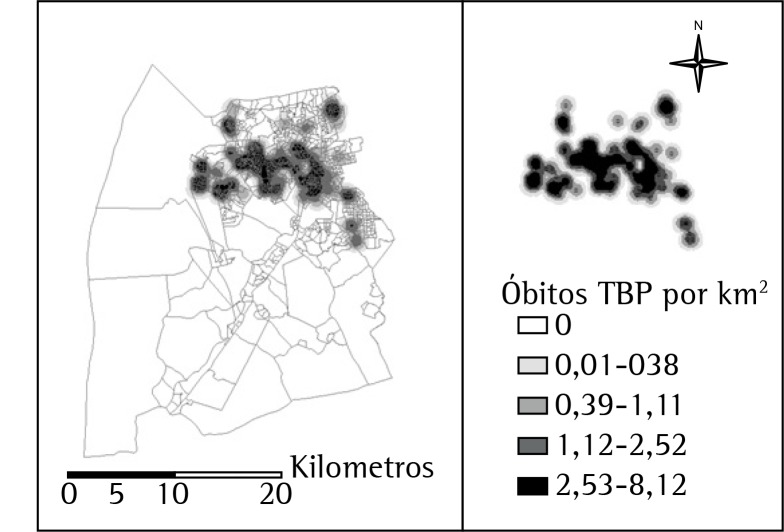
Mapa da distribuição da densidade de pontos dos óbitos por tuberculose
pulmonar (TBP) ocorridos na zona urbana de São Luís (MA), 2008-2012.